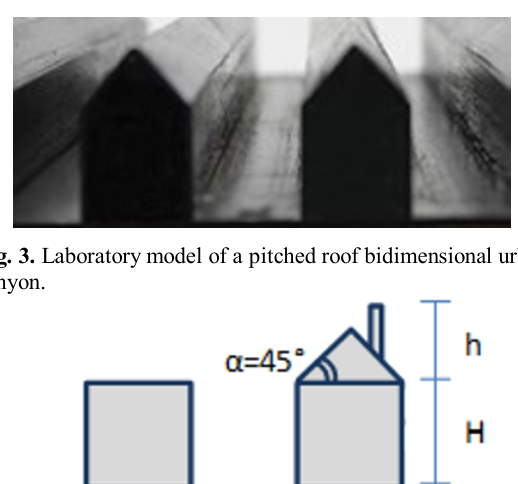
Fig. 2. Laboratory model of a flat roof bidimensional urban canyon.